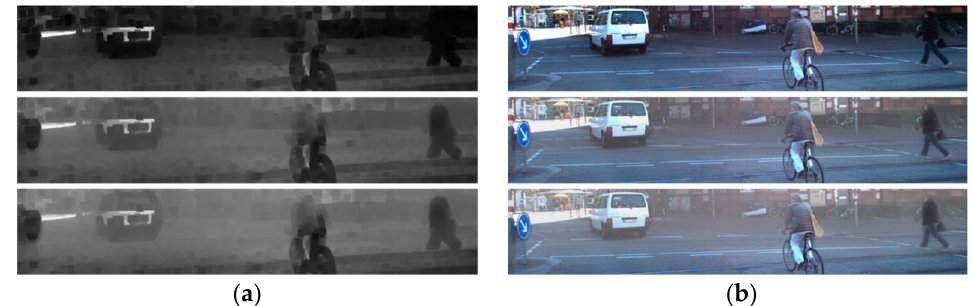
Figure 8. Generated dark channel depending on different intensity of haze: ( a ) dark channel; ( b ) hazy image.